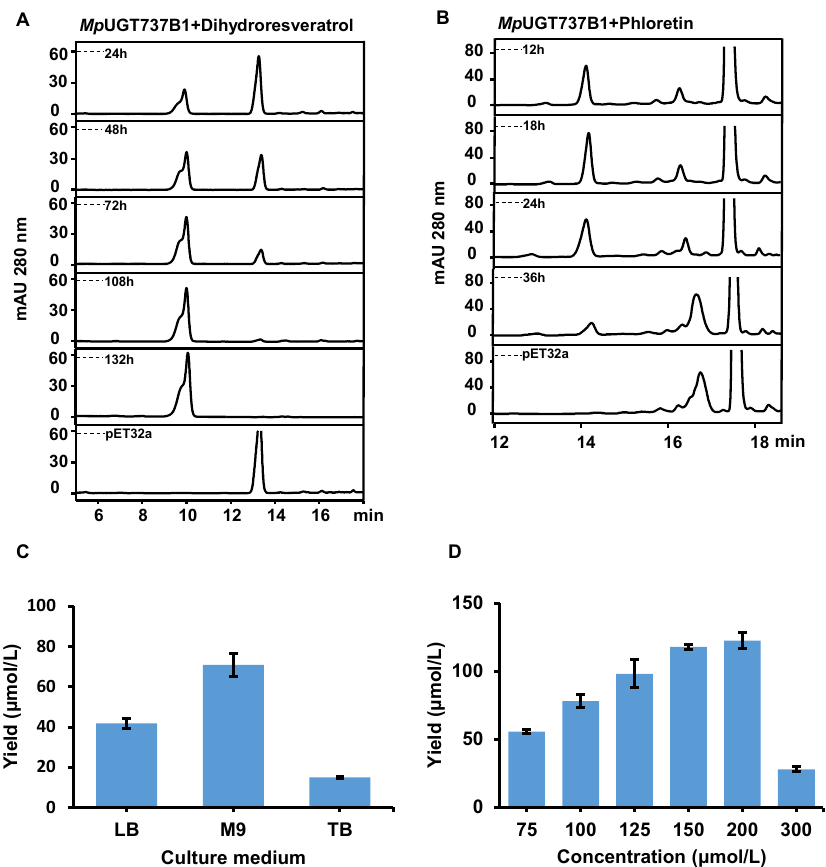
Figure 3. Production of 4- O -glucosides by bioconversion using E. coli Mp UGT737B1. HPLC analysis of recombinant E. coli Mp UGT737B1 strain to produce O -glucosides when fed with either ( A ) 100 µ M dihydroresveratrol or ( B ) 100 µ M phloretin. ( C ) The effect of culture medium on the production of phloretin-4- O -glucoside. ( D ) The effect of phloretin concentrations on the production of phloretin-4- O -glucoside. Three replicates were carried out for each analysis and the error bars indicate the SD.